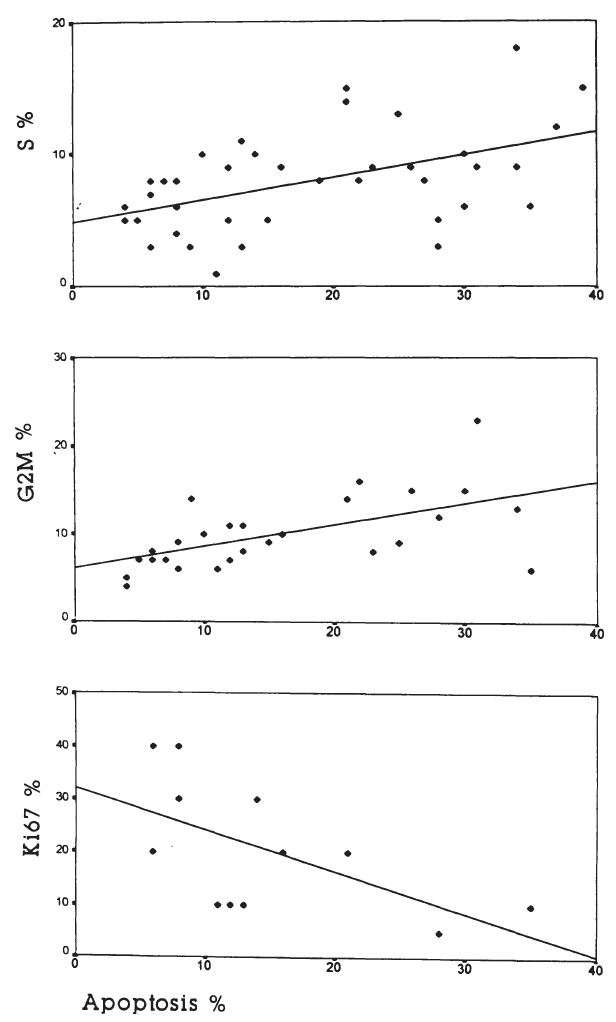
Fig. 4. Correlation between apoptosis and proliferation in colorectal mucosa. Top: Apoptotic cells % vs. S % ( ρ = 0 . 369, p < 0 . 05, N = 29). Middle: Apoptotic cells % vs. G2M % ( ρ = 0 . 592, p < 0 . 001, N = 29). Bottom: Apoptotic cells % vs. Ki67 positive cells % ( ρ = − 0 . 612, p = 0 . 06, N =